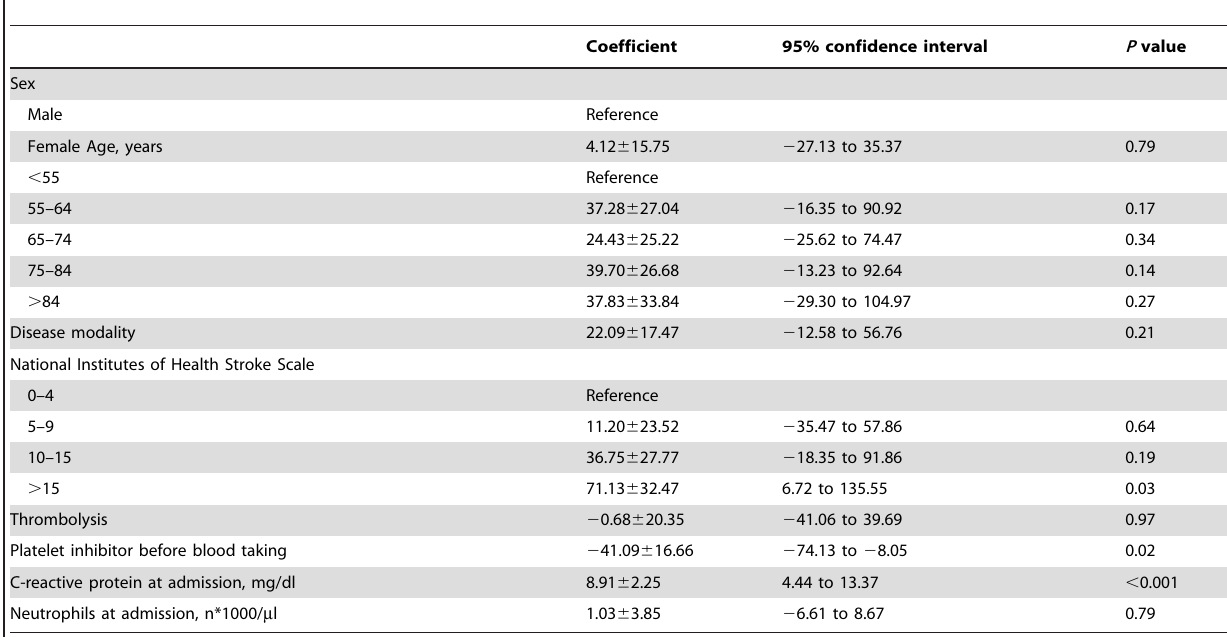
Table 3. Predictors of von Willebrand factor levels in acute ischemic stroke (AIS)/transitory ischemic attack (TIA) patientsby multivariate analysis